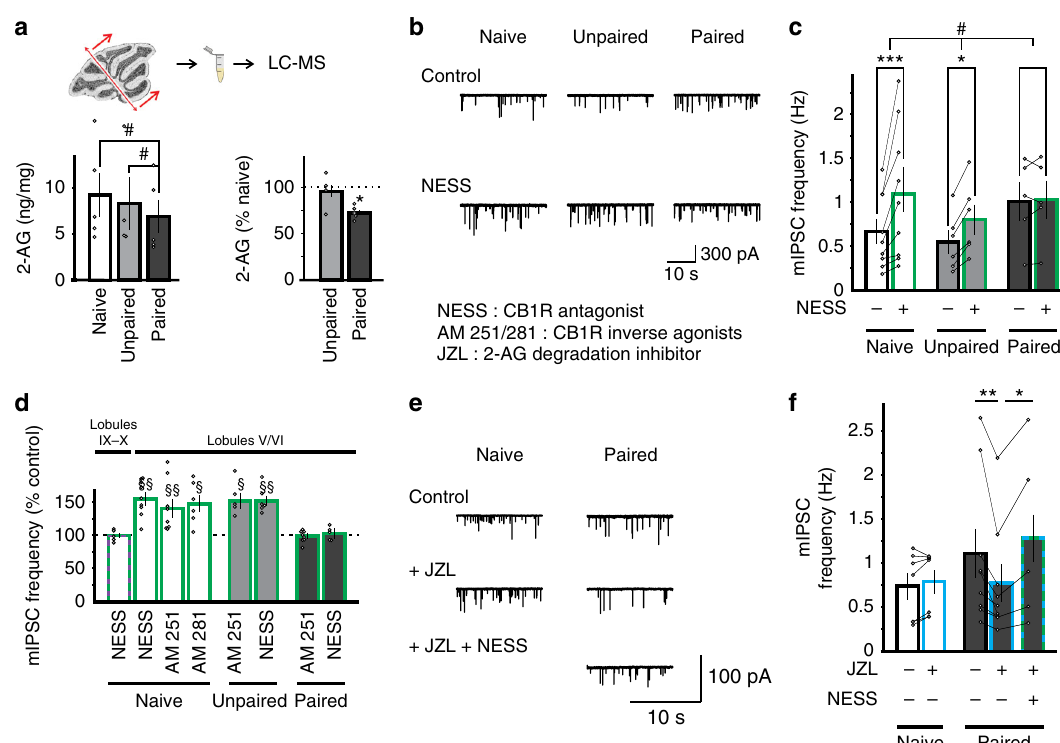
Fig. 7 Increased 2-AG degradation after fear conditioning abolishes the tonic endocannabinoid signaling in lobules V/VI. a Top, lobules I to VI/VII of the cerebellar vermis were dissected out and lipids were extracted for LC-MS measurements. Bottom, The 2-AG content from conditioned mice (paired, n = 5 animals, 1 sample/animal) was signi fi cantly lower when compared to naïve mice ( n = 5 animals) or after the unpaired protocol ( n = 4 animals; one- way ANOVA, P = 0.013; tukey post-hoc, paired vs naïve, P = 0.014; paired vs unpaired, P = 0.045). b Representative mIPSC recordings from stellate cells in lobules V/VI of naïve and unpaired controls and conditioned mice before and during application of a CB1R antagonist, 0.5 µ M NESS 0327 . c Group data showing that NESS application elevated mIPSC frequency in naïve and unpaired, but not paired animals (two-way RM ANOVA, P = 0.034, #; followed by Tukey ’ s post hoc test: *, P = 0.026; ***, P < 0.001). d Effects of a CB1R neutral antagonist NESS 0327 (naïve lobules IX/X n = 5 cells, naïve lobules V/VI n = 9 cells, unpaired n = 6 cells, paired n = 5 cells), inverse agonists, 5 µ M AM 251 (naïve n = 8 cells, unpaired n = 5 cells, paired n = 8 cells) and 5 µ M AM 281 ( n = 6 cells), on mIPSC frequency in cells from lobules V/VI and IX/X were normalized to before drug application. e Representative mIPSC recordings in stellate cells before and during application of the MAGL inhibitor JZL 184 in slices from naive and fear conditioned mice. Application of NESS 0327 to inhibit CB1Rs restored mIPSC frequency in conditioned animals to control levels. f Group data showing that JZL 184 or JZL 195 ( n = 7 cells) did not change